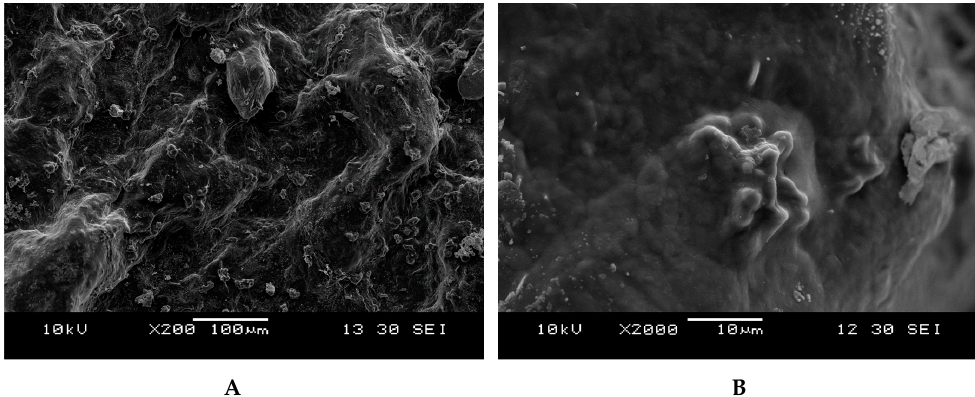
Figure 2. Scanning electron micrograph of G. blodgettii polysaccharide: magnification ( A ) 200×; ( B ) magnification 2000×.